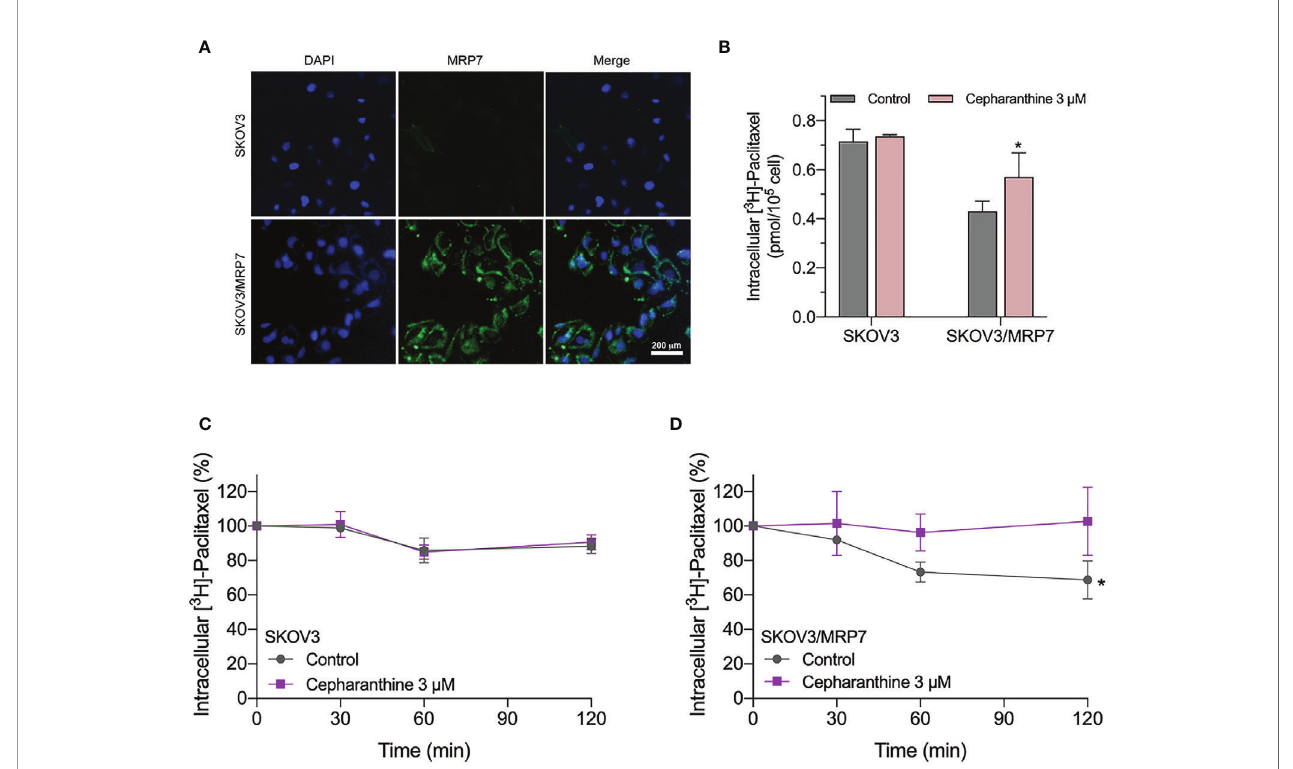
FIGURE 3 | Immuno fl uorescence assay and accumulation-ef fl ux assays of colony 1. (A) Subcellular localization of MRP7 in SKOV3 and SKOV3/MRP7 cells. (B) The intracellular accumulation of [ 3 H]-paclitaxel in SKOV3 and SKOV3/MRP7 cells. (C) The ef fl ux of [ 3 H]-paclitaxel in SKOV3 cells. (D) The ef fl ux of [ 3 H]-paclitaxel in SKOV3/MRP7 cells. Data in (B – D) are expressed as mean ± SD derived from three independent experiments. *p < 0.05 versus the control